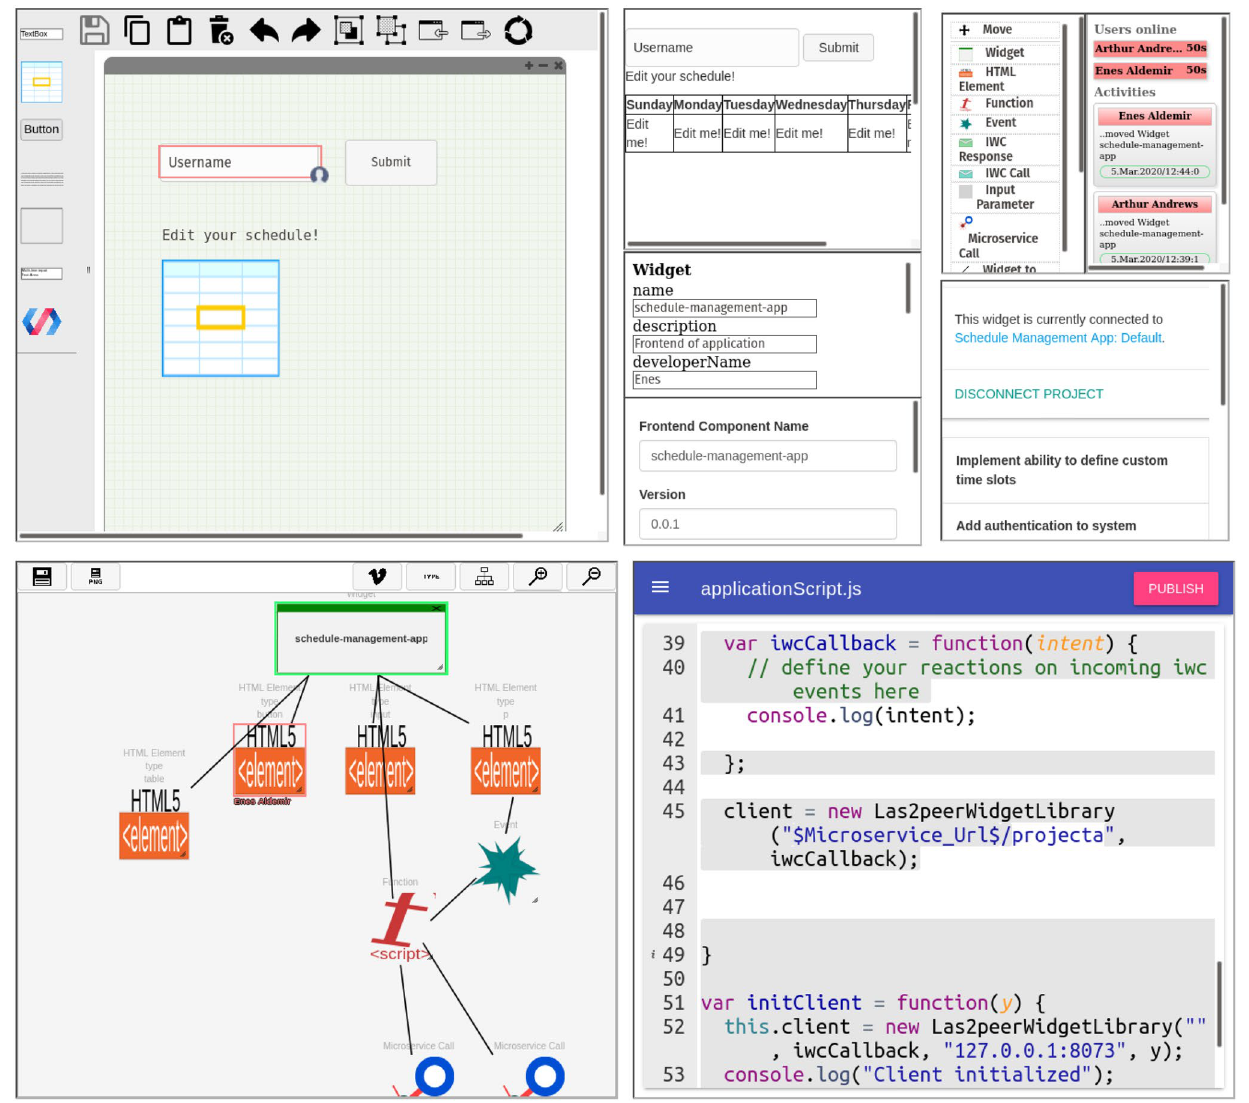
Fig. 7 Screenshot of the